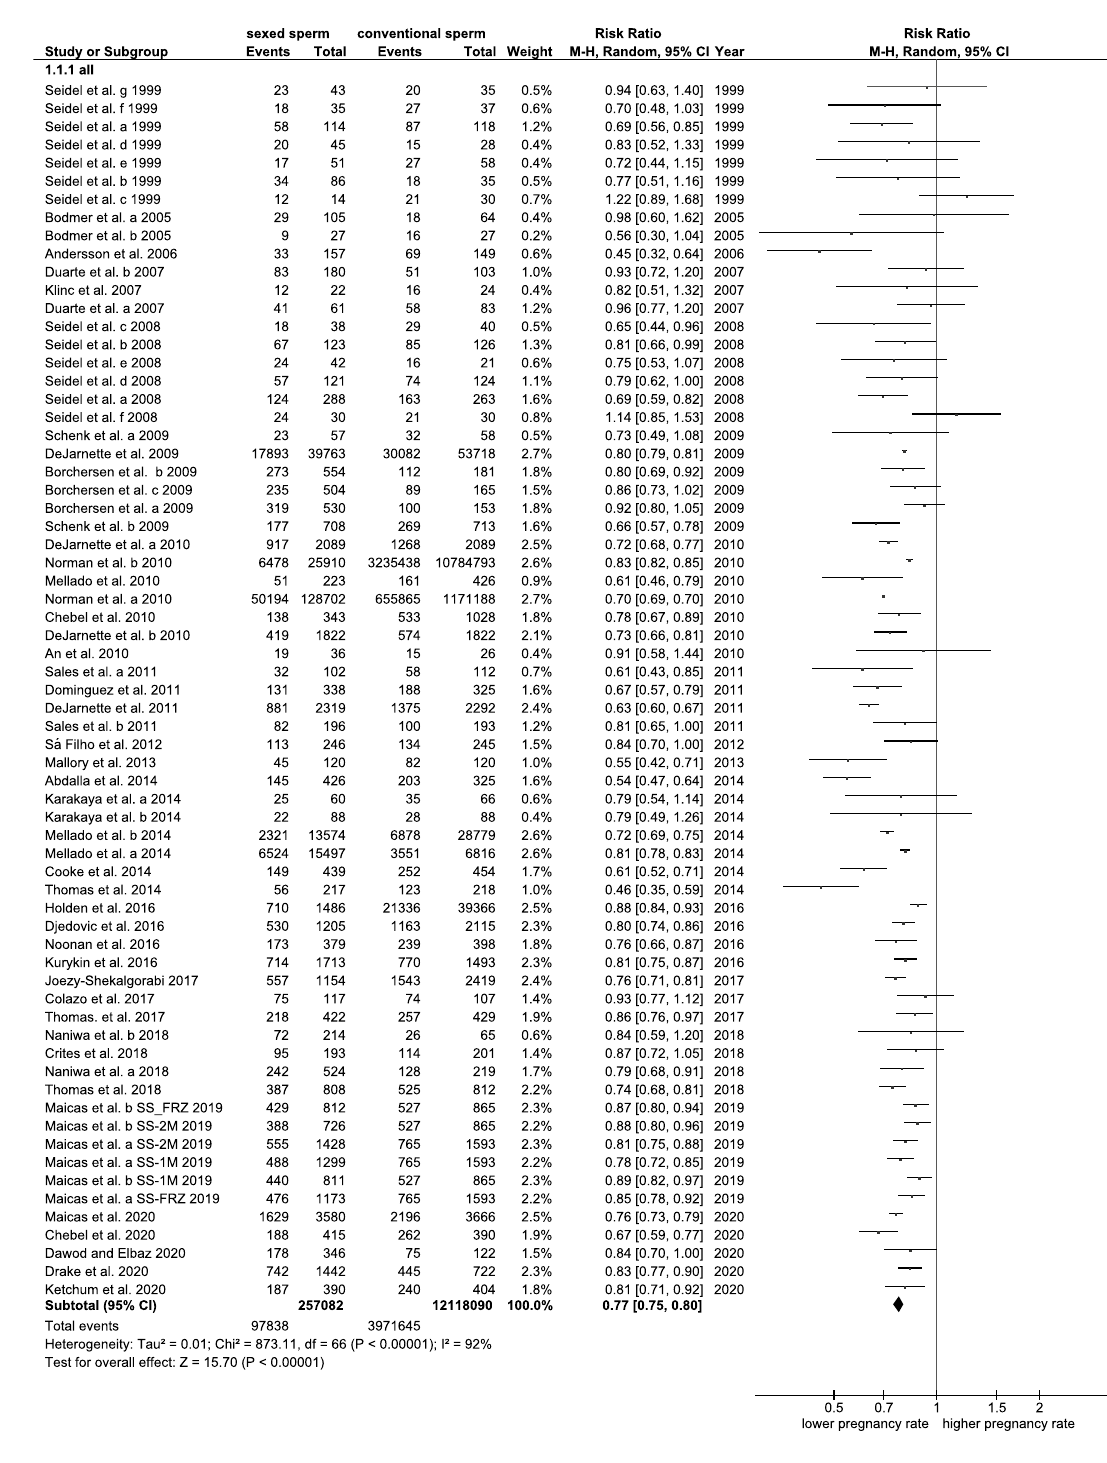
Figure 3. Forest plot of the pregnancy rates after the use of sex-sorted sperm compared to conventional